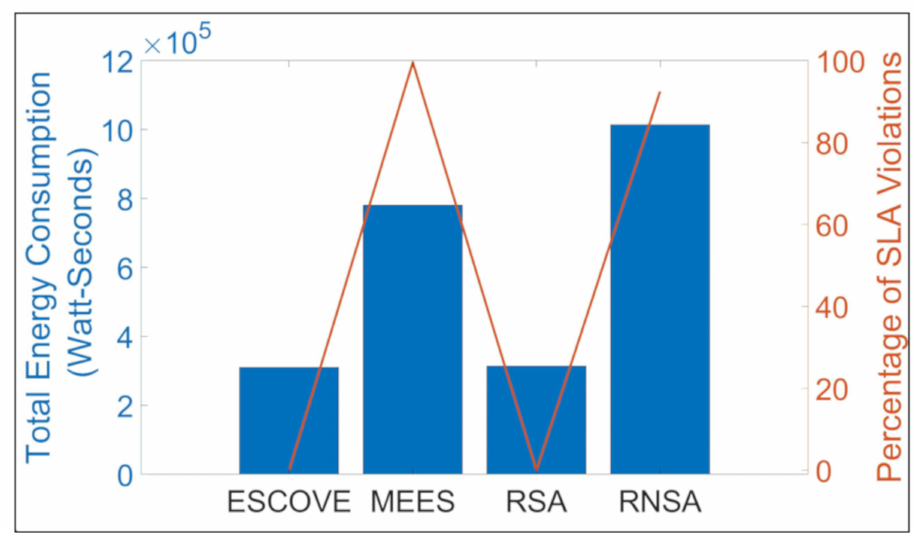
Figure 12. Total energy consumption and percentage SLAVs using ESCOVE, RNSA, and RSA.